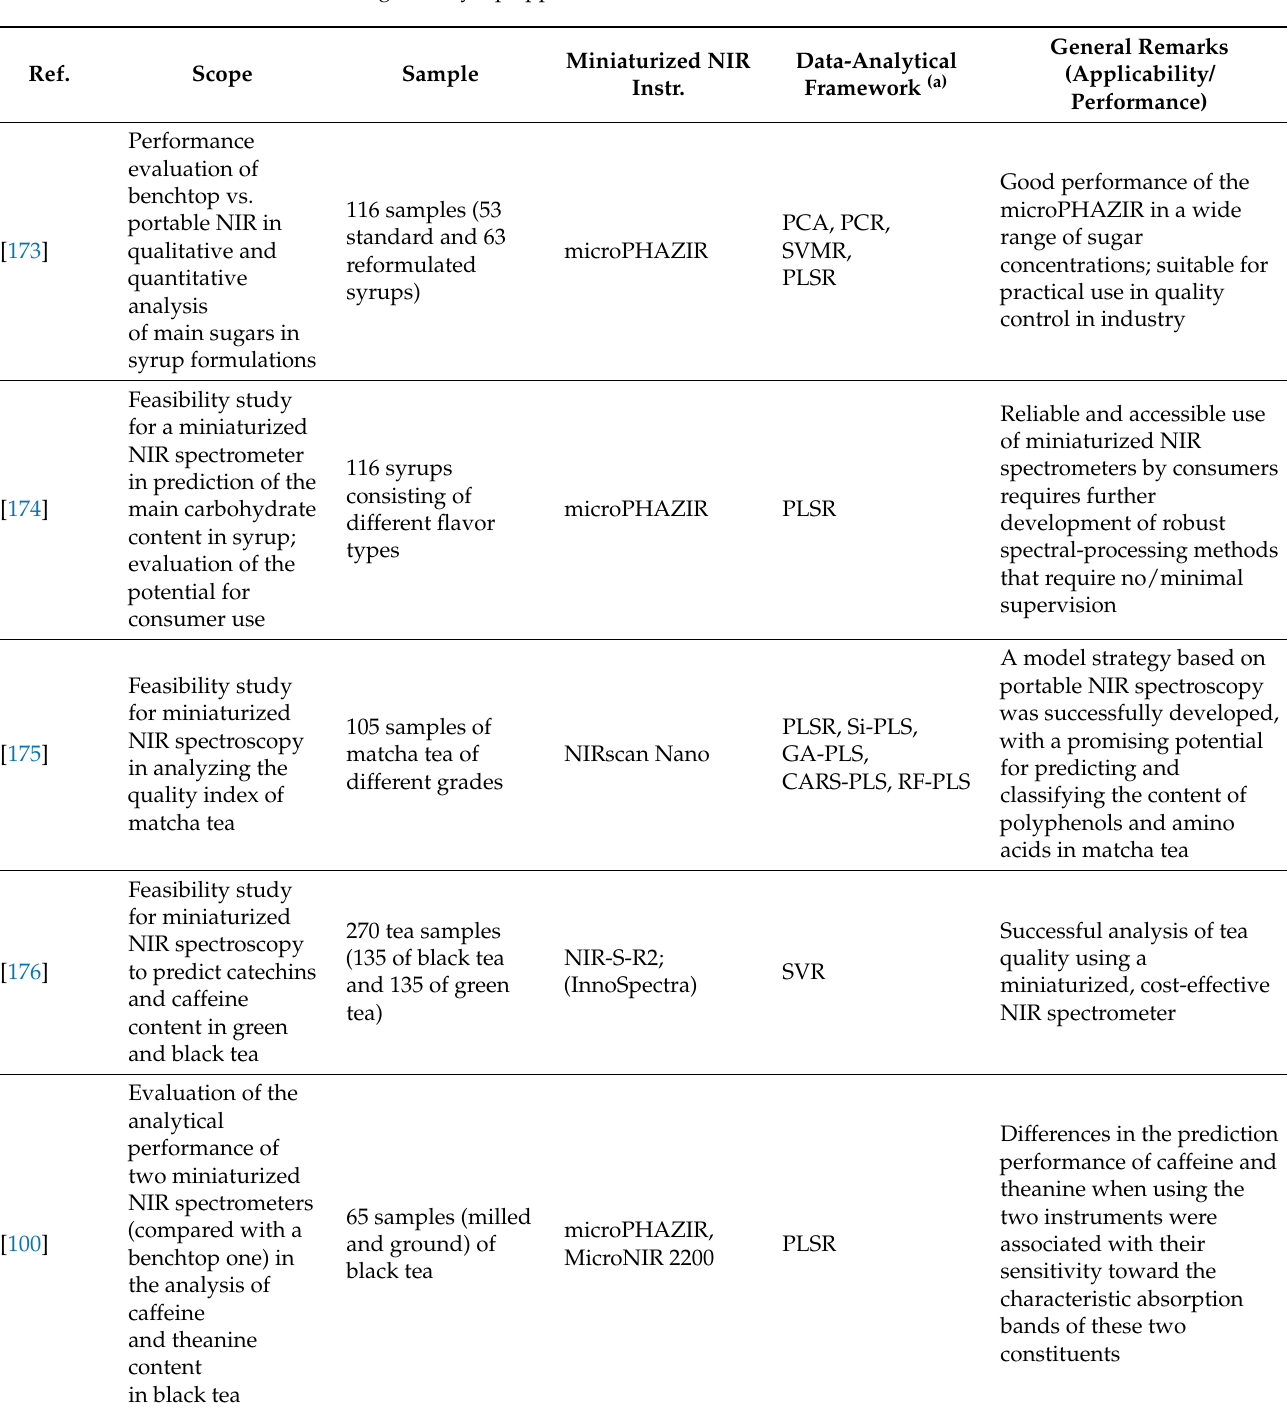
Table 8. Recent research activity oriented toward miniaturized NIR spectroscopy in the area of beverage and syrup